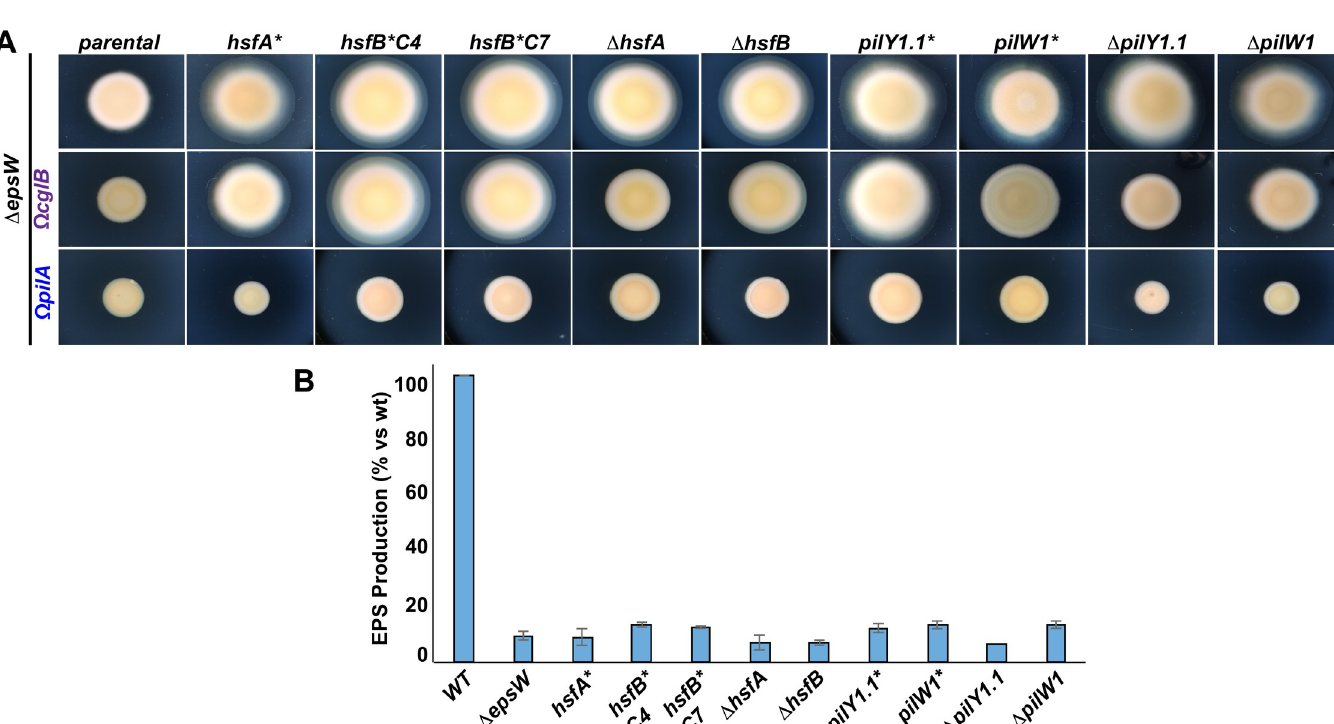
Fig 2. Δ epsW suppressors are loss-of-function mutants and their motility restoration is T4P dependent and EPS-independent. (A) Motility assays of backcrossed suppressors and in-frame deletion mutants in Δ epsW , Δ epsWΩcglB and Δ epsWΩpilA backgrounds on 0.5% agar at 72H. hsfA � corresponds to suppressor C9, hsfB � C4 to C4, hsfB � C7 to C7, pilY1 . 1 � to C10/C11/C12, pilW1 � to C8. (B) Trypan Blue assays showing the relative EPS production of the indicated strains. All data represents the mean and standard deviation of at least three biological replicates. Raw data are available in S4 Table.